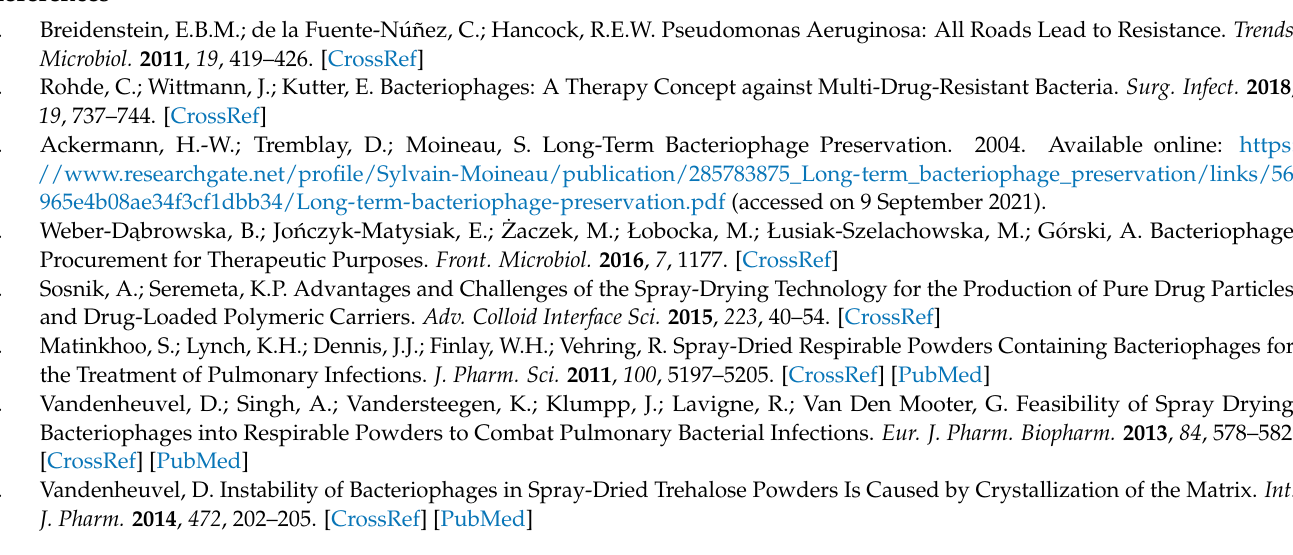
for the LUZ19 experiments.; Figure S2. Temperature outlet, 3D surface graph for 14-1.; Table S1. Fit statistics for the models.; Figure S3. Process yield, one-factor effect graphs with 95% CI bands for the LUZ19 experiments.; Figure S4. Process yield, one-factor effect graphs with 95% CI bands for the 14-1 experiments.; Figure S5. RMC, one-factor effect graphs with 95% CI bands for the LUZ19 experiments.; Figure S6. RMC, one-factor effect graphs with 95% CI bands for the 14-1 experiments.; Figure S7. Dynamic Vapor Sorption (DVS) analyses for optimized spray-dried powder containing LUZ19 (A & B) and 14-1 (C&D) at +5 ◦ C, as well as LUZ19 at +25 ◦ C (E & F).; Figure S8. XRD profiles of optimized spray-dried powder containing LUZ19 stored at 5 ◦ C (A) and 40 ◦ C, 75% RH (B) over time, and at day 1 (C) and at 1 year (D) storage under different ICH conditions.; Figure S9. XRD profiles of optimized spray-dried powder containing 14-1 stored at 5 ◦ C (A) and 40 ◦ C, 75% RH (B) over time, and at day 1 (C) and at 1 year (D) storage under different ICH